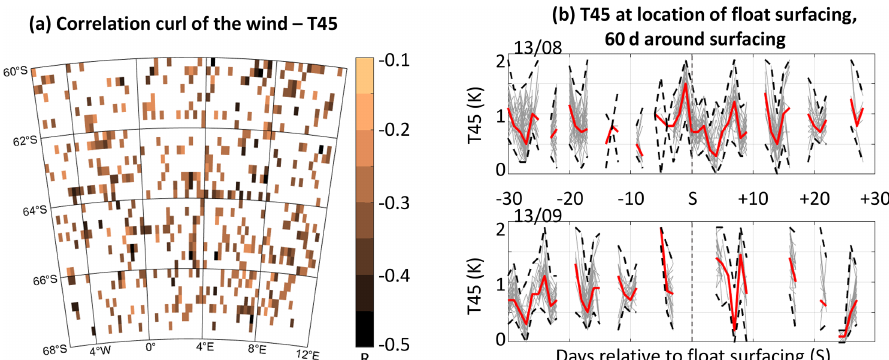
Figure 8. (a) Correlation between daily curl of the wind and T45 for the polynya years over 1 July to 31 October, with T45 interpolated onto the wind grid. Only significant negative correlations are shown. (b) Time series of all T45 (grey) in a 14km radius around the location of the float surfacing, with median (red) and extrema (black dashed) highlighted, 30d before to 30d after surfacing on 13 August 2017 (top) and 13 September 2017